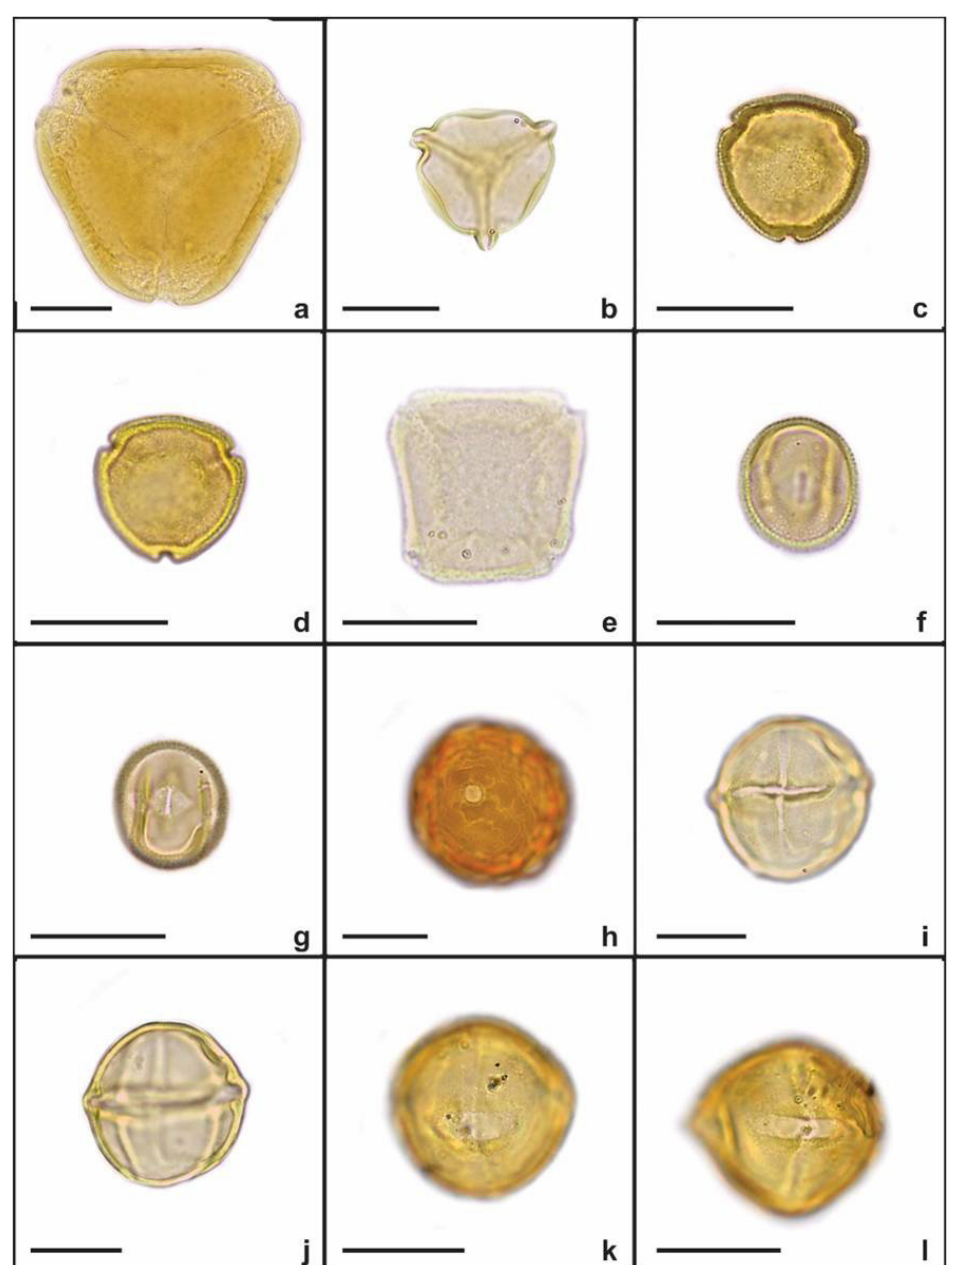
Fig 1. Pollen types identified in nests of Centris ( Centris ) flavifrons in an urban area. Fabaceae: a. Dioclea . Lythraceae: b. Cuphea . Myrtaceae: c-d. Myrcia type 1. e. Psidium . Malpighiaceae: f-g. Byrsonima sericea . h. Stigmaphyllum blanchetii . Solancaceae: i-j. Cestrum . k-l. Solanum paniculatum .